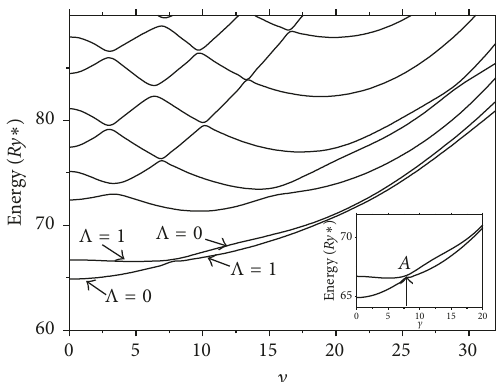
Figure 9: Energies of the off-axis donor in elongated QR with parameters 𝑎 = 20 nm, 𝑑 𝑟 = 4nm, 𝑑 ℎ = 2 nm, and 𝑒 = 1.0 as functions of the external magnetic